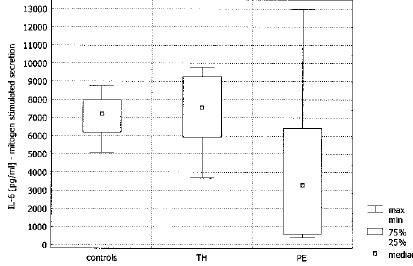
FIG. 6. Comparison of IL-12 PHA-stimulated secretion in healthy pregnant women (controls) ( n = 11), and pregnant women with transient hypertension (TH) ( n = 17) and pre- eclampsia (PE) ( n = 21). Statistically significant are the differences between controls and PE ( p < 0.05).